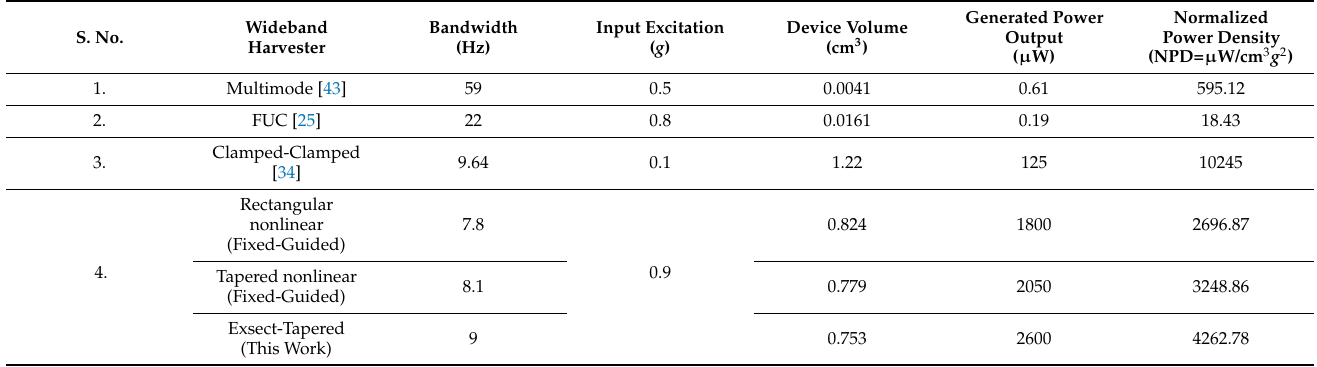
Table 4. Comparison of reported nonlinear wideband piezoelectric energy